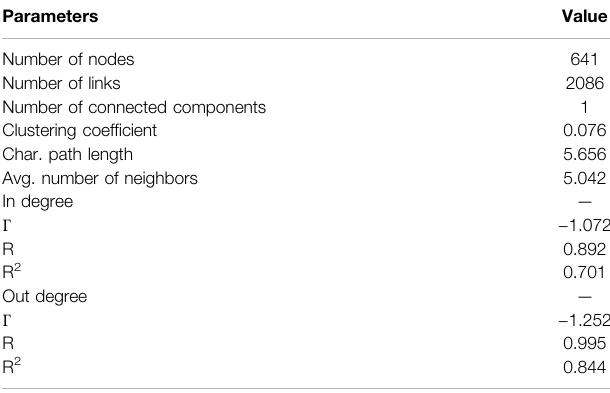
Table showing the results of topological analyses of the network obtained from the WOS_MM iv F